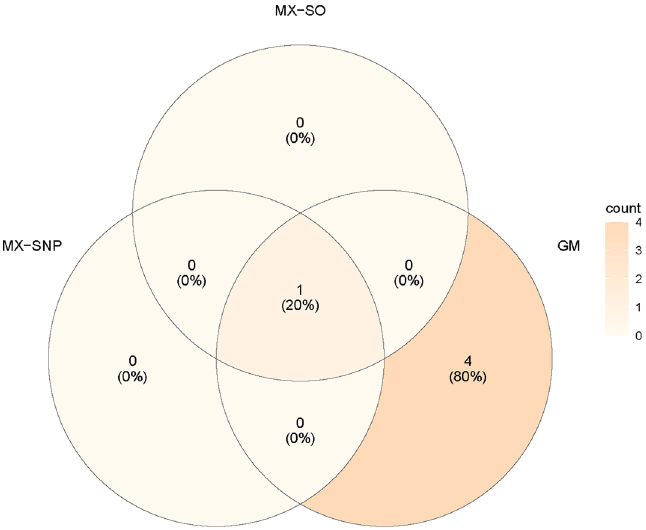
Figure 4. The consistency among PPMI-associated genes selected by model-X knockoff models and Gaussian